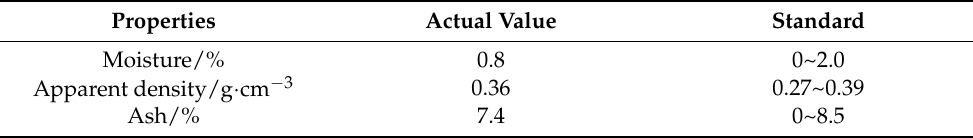
Table 1. Properties of